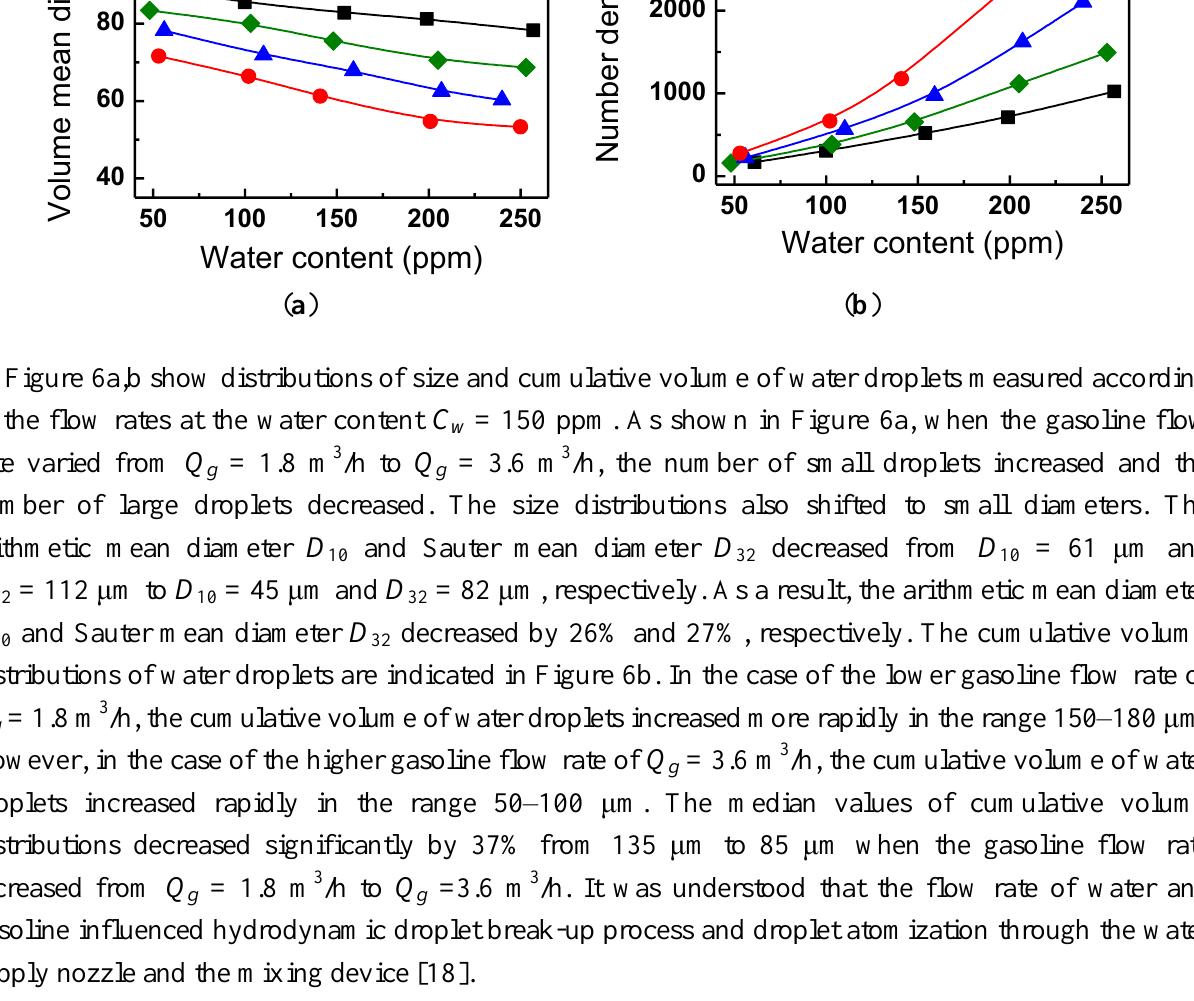
Figure 5. Volume mean diameter and number density of water droplets: ( a ) volume mean diameter D ; ( b ) number density N . 30